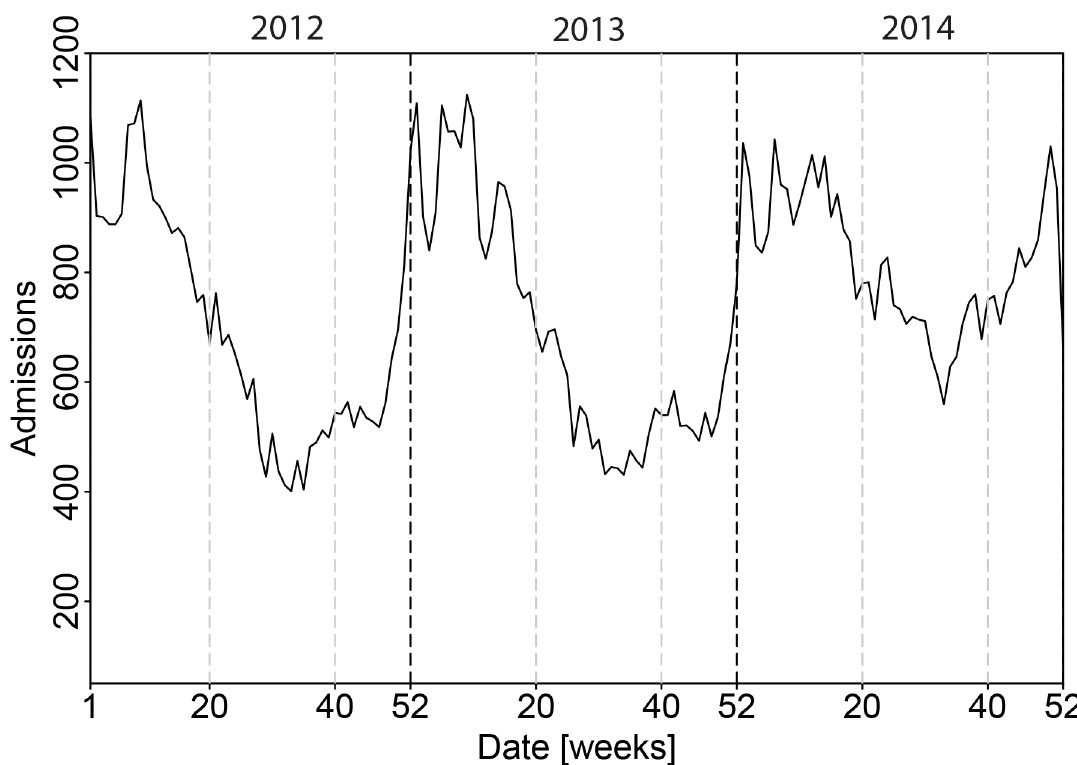
Fig 1. Time series of unspecified pneumonia (ICD-10 discharge diagnosis J18) hospitalisation cases plotted on a weekly basis.